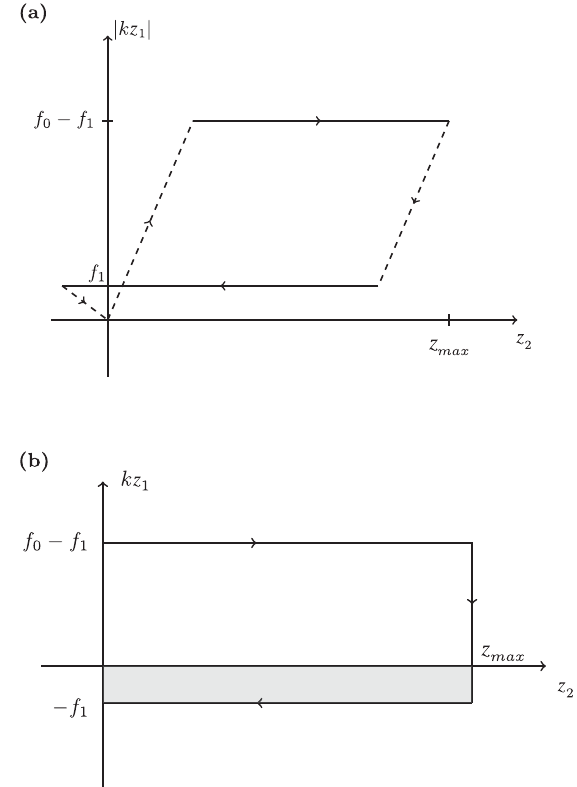
j vs deformation z for the 1 2